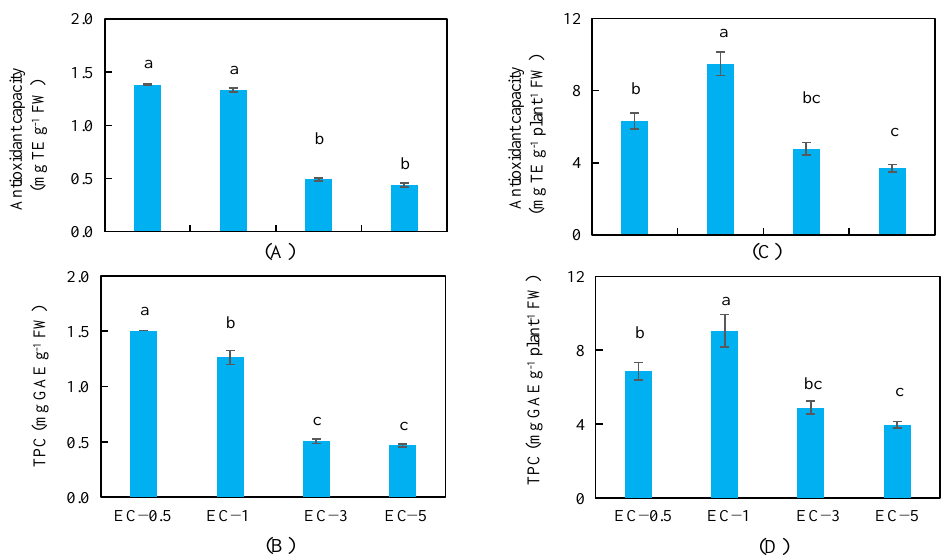
Figure 3. The antioxidant capacity in basil leaves ( A ), total phenolic content (TPC) ( B ) in basil leaves, antioxidant capacity in leaves of the whole plant ( C ), and TPC in leaves of the whole plant ( D ) under 4 different EC treatments at 34 days after sowing. The error bars represent SEs ( n = 8). Different lowercase letters represent significant differences among different EC treatments based on Tukey’s new multiple range test at p <